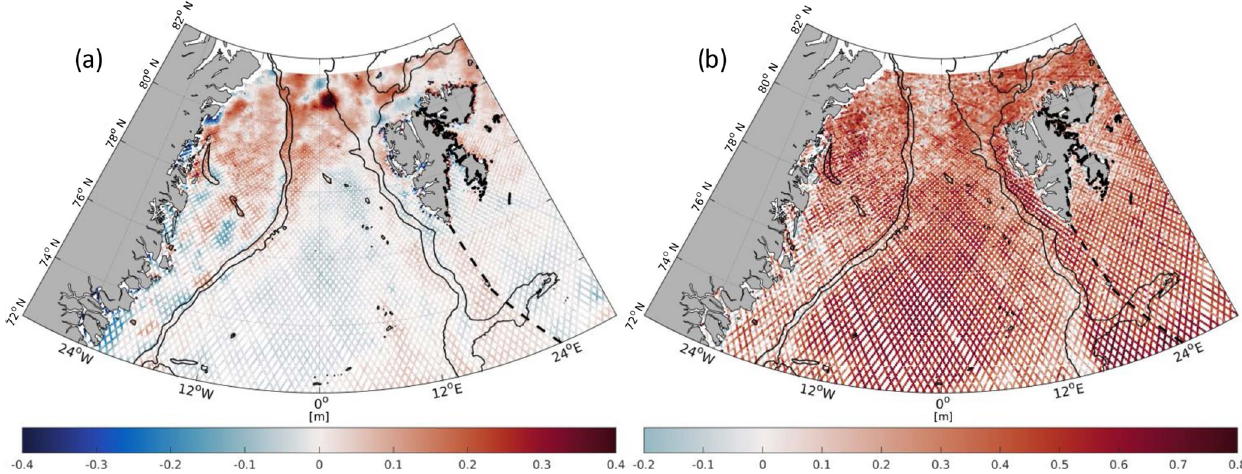
Figure 9. Differences (a) and correlations (b) between altimetry and FESOM binned along-track residual DOT within the investigation